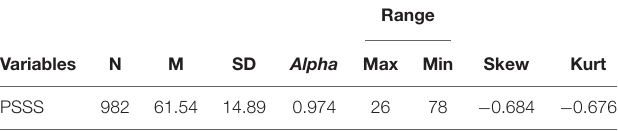
TABLE 2 | Psychometrics properties of major study